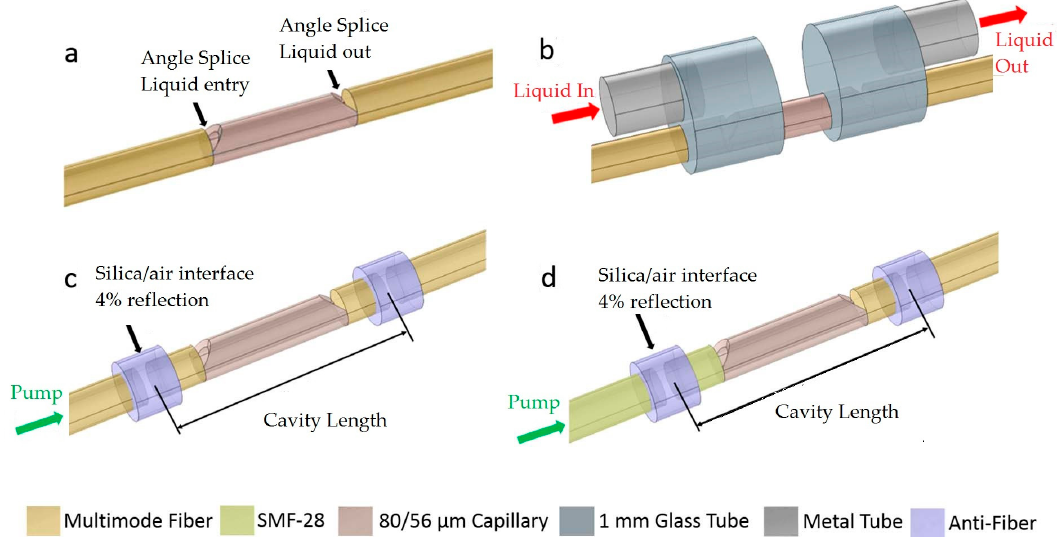
Figure 4. Device schemes of the all-fiber high-repetition-rate microfluidic dye lasers. ( a ) Angle-cleaved capillary spliced to conventional fibers, allowing for liquid flow; ( b ) a whole device, including the pressure cells formed by glass tubes and their connection to liquid reservoirs via metal tubes; ( c ) multimode laser cavity, including air gaps for the feedback via Fresnel reflection; ( d ) few-mode laser cavity with similar air gaps but with a small-core fiber (SMF-28) in one side to provide modal filtering. Anti-fiber is the capillary (inner diameter 128 μ m) used to generate the air gaps [33].